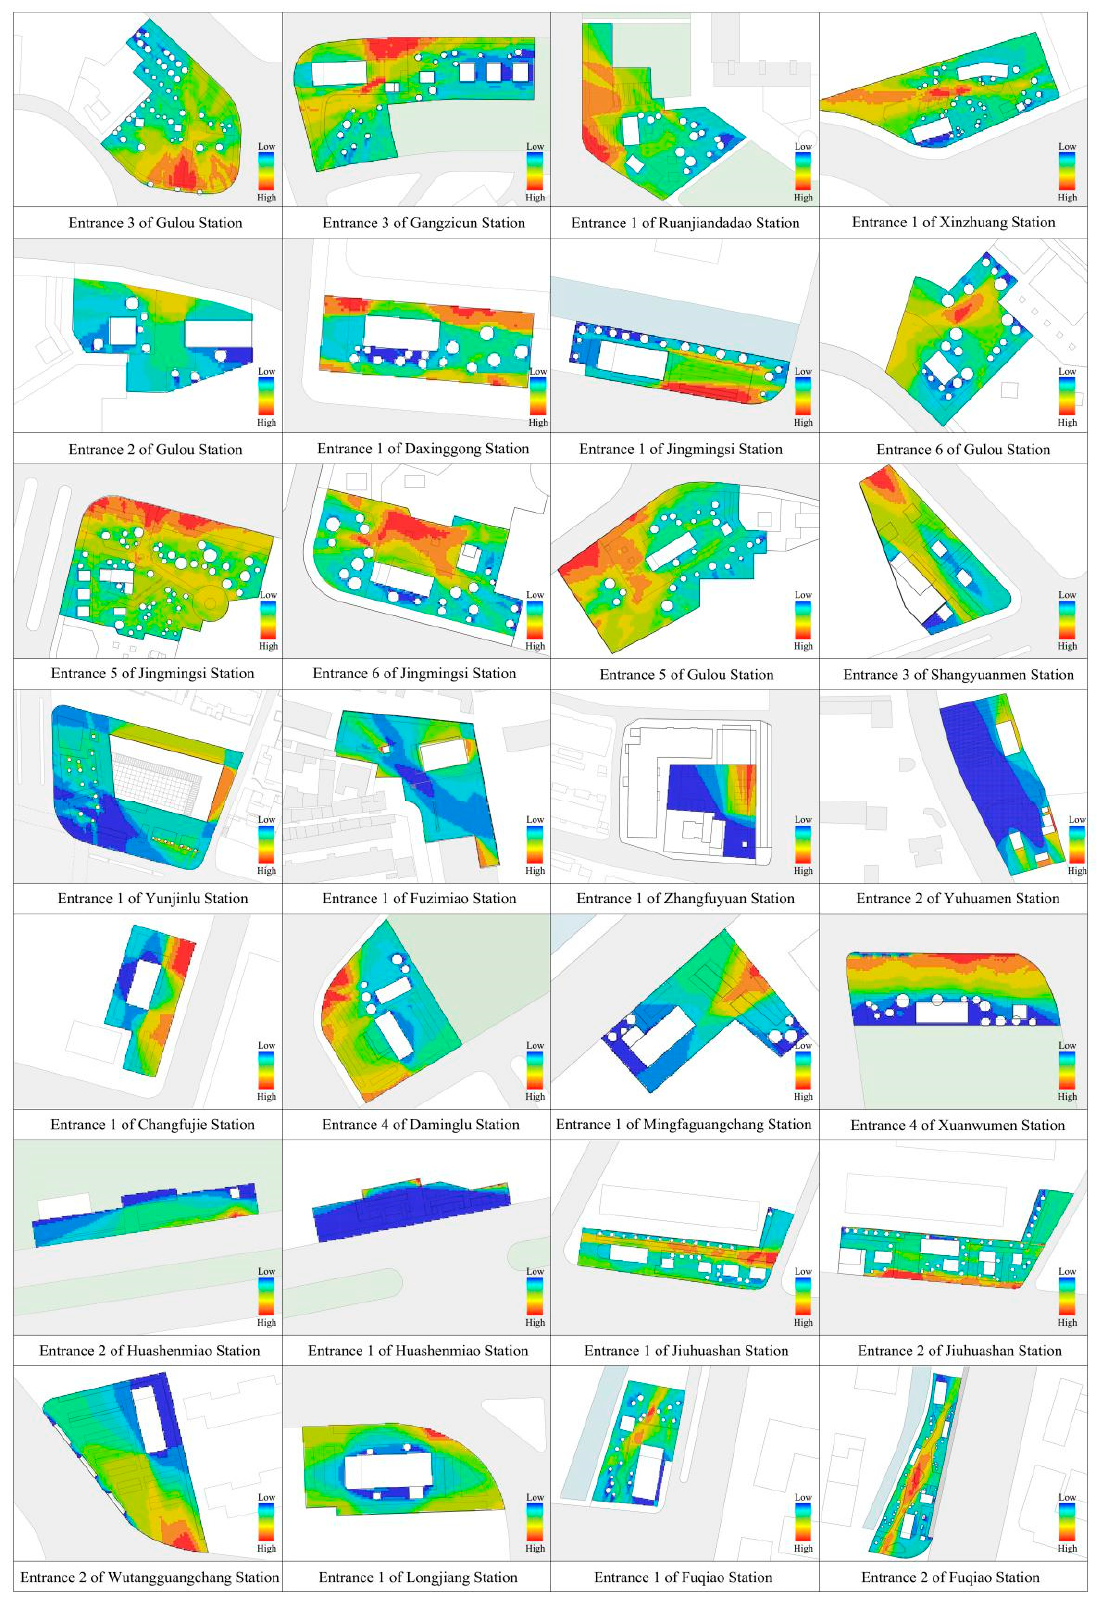
Figure 5. Examples of acquisition results of visual